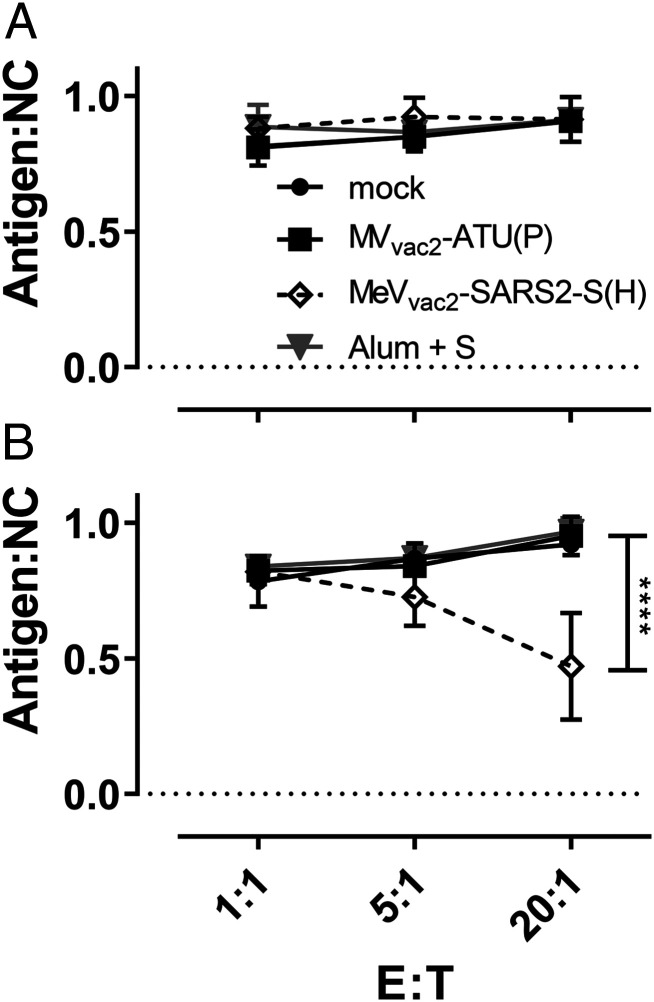
Antigen-specific killing activity of SARS-CoV-2 S-specific T cells. Killing assay using splenocytes of mice vaccinated on days 0 and 28 isolated 21 d after the second immunization. Splenocytes were cocultured (A) with DC2.4 or (B) with antigen-presenting DC2.4-SARS2-S cells for 6 d. Activated CTLs were then cocultured with EL-4green-SARS2-S target cells (Antigen) and EL-4red control cells (NC) at indicated E:T ratios for 4 h. Ratio of living target to nontarget cells (Antigen:NC) was determined by flow cytometry. Depicted are means and SD of each group (open diamonds, MeVvac2-SARS2-S(H); filled circles, mock; filled squares, MVvac2-ATU(P); gray triangles, S protein + Alum) (n = 4 to 6). For statistical analysis, two-way ANOVA analysis was applied with paired Tukey’s multicomparison test used as post hoc test. E:T, effector cell : target cell ratio; ****P < 0.0001.